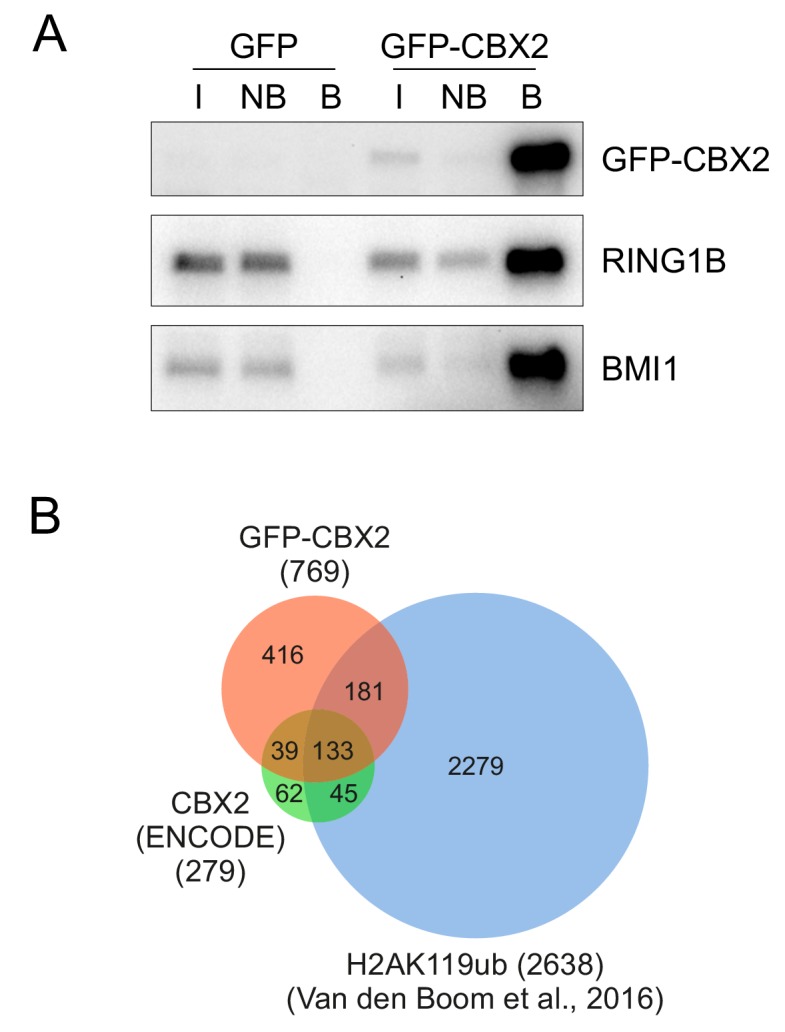
GFP-CBX2 is incorporated in the PRC1 complex and shows overlapping chromatin binding compared to endogenous CBX2 and H2AK119ub.(A) Western analysis of GFP pull-outs performed on K562 GFP and K562 GFP-CBX2 cells showing co-preciptation of endogenous RING1B and BMI1 with GFP-CBX2. (B) Venn diagram showing overlap between identified target genes based on peak calling on tracks for GFP-CBX2 (K562 GFP-CBX2 cells, this paper), endogenous CBX2 (K562 cells, ENCODE/Broad) and H2AK119ub (K562 cells, described in van den Boom et al., 2016.